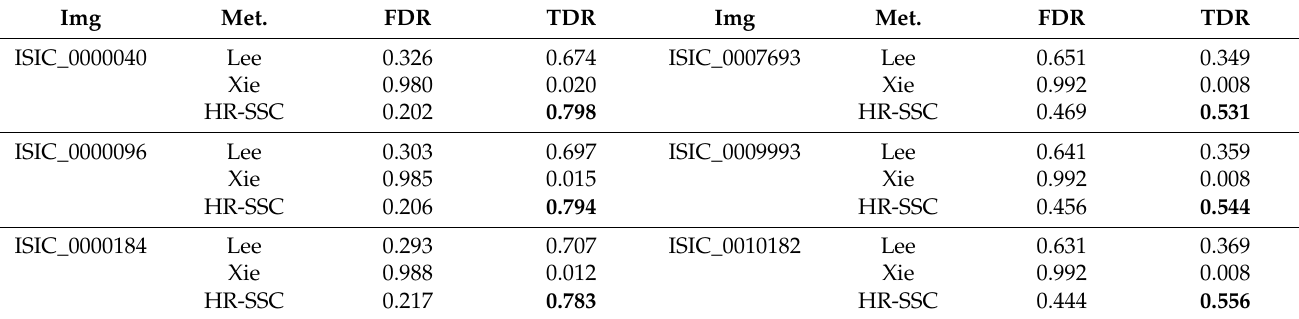
Table 7. False discovery rate (FDR) and true discovery rate (TDR) on sHSim-data—best results are in bold. Img Met.